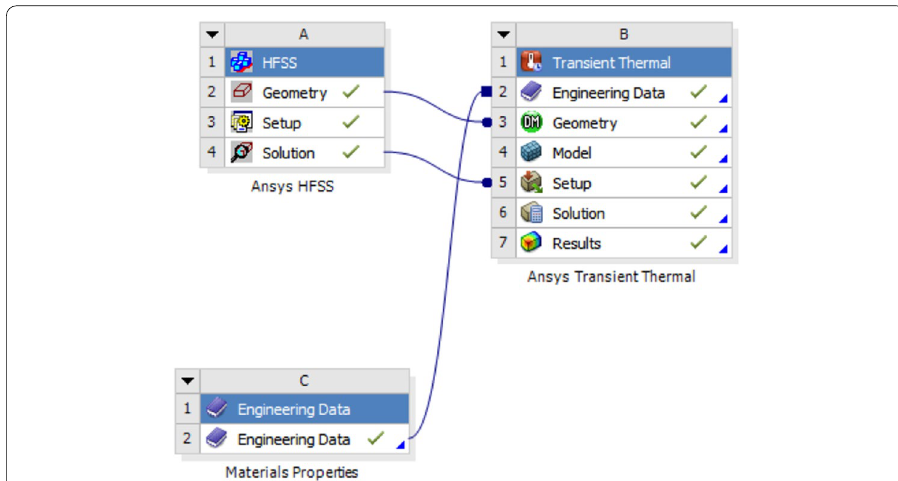
Fig. 3 One-way EM-thermal link in the Ansys Workbench software